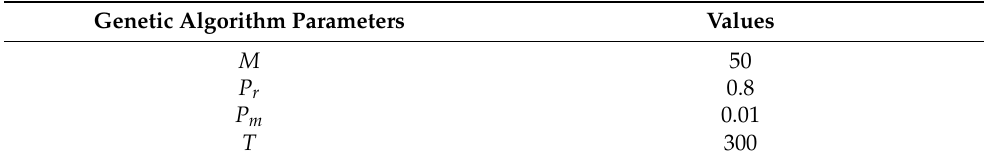
Table 1. Operating parameters of genetic algorithm. Genetic Algorithm